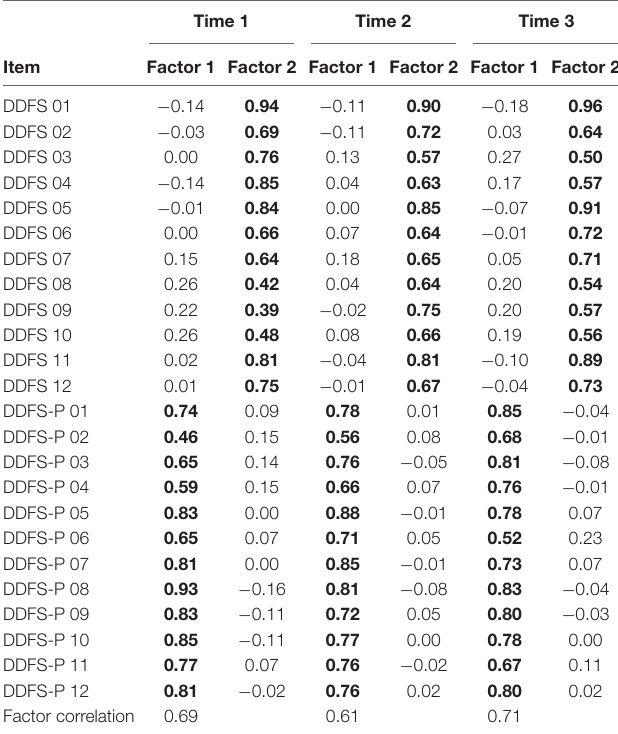
daydreaming and general daydreaming on subsequent marital TABLE 1 | Factor loadings and correlations based on the exploratory factor analyses of the general and partner-related daydreaming scale